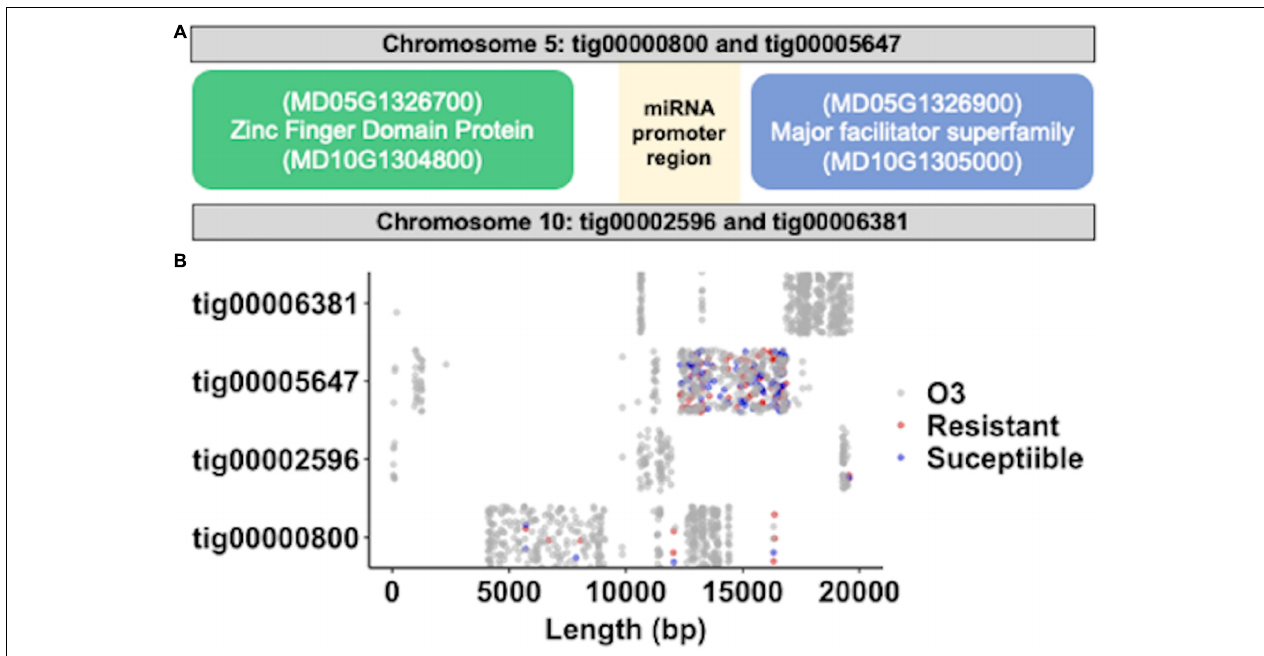
FIGURE 6 | Genomic location of miR397a, expression variant analysis. (A) Illustration of physical map around MIR397a. The two regions on chromosome 5 and 10 that matches MIR397a containing contigs are shown. The relative upstream and downstream sequences from MIR397a position was used to identify the annotated genes including zinc finger domain protein and a major facilitator superfamily protein on the two apple chromosomes. (B) Distribution of variants across the four MIR397a matching “Robusta 5” contigs after its comparison with the “O3” parent (gray dots), resistance (red dots), and susceptible (blue dots)